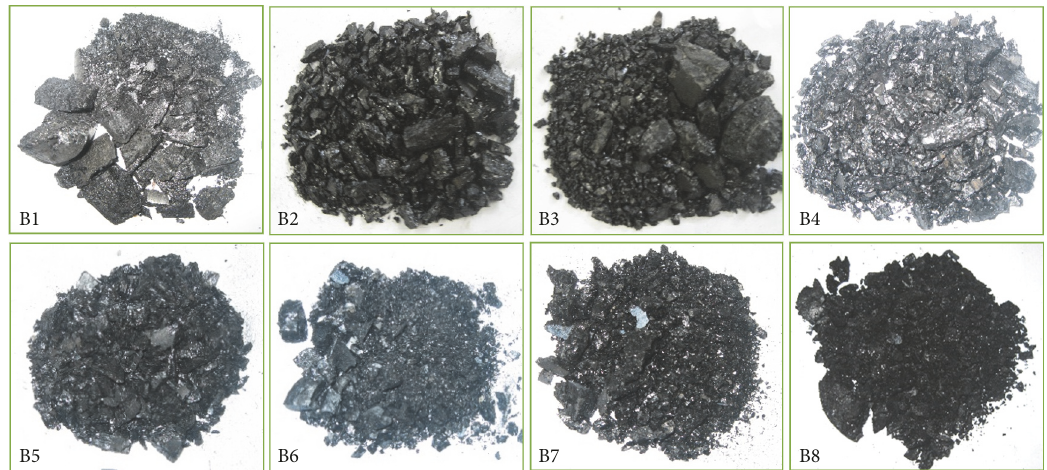
Figure 15: Failure forms of natural and 7D saturated specimens under uniaxial static-dynamic